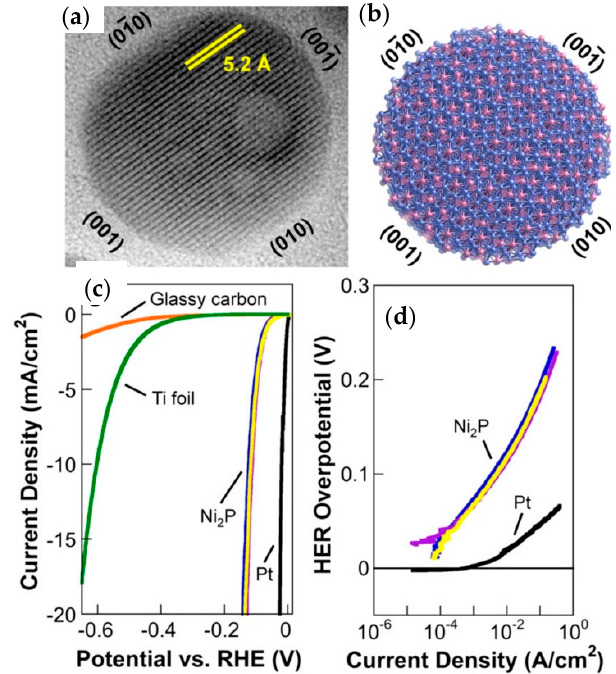
Figure 7. ( a ) High resolution TEM image of a representative Ni 2 P nanoparticle, highlighting the exposed Ni 2 P (001) facet and the 5.2 Å lattice fringes that correspond to the (010) planes; ( b ) Proposed structural model of the Ni 2 P nanoparticles; ( c ) Polarization data for three individual Ni 2 P electrodes in 0.5 M H 2 SO 4 , along with glassy carbon, Ti foil, and Pt in 0.5 M H 2 SO 4 , for comparison; ( d ) Corresponding Tafel plots for the Ni 2 P and Pt electrodes. Reprinted with permission from [125]. Copyright 2013 American Chemical Society.